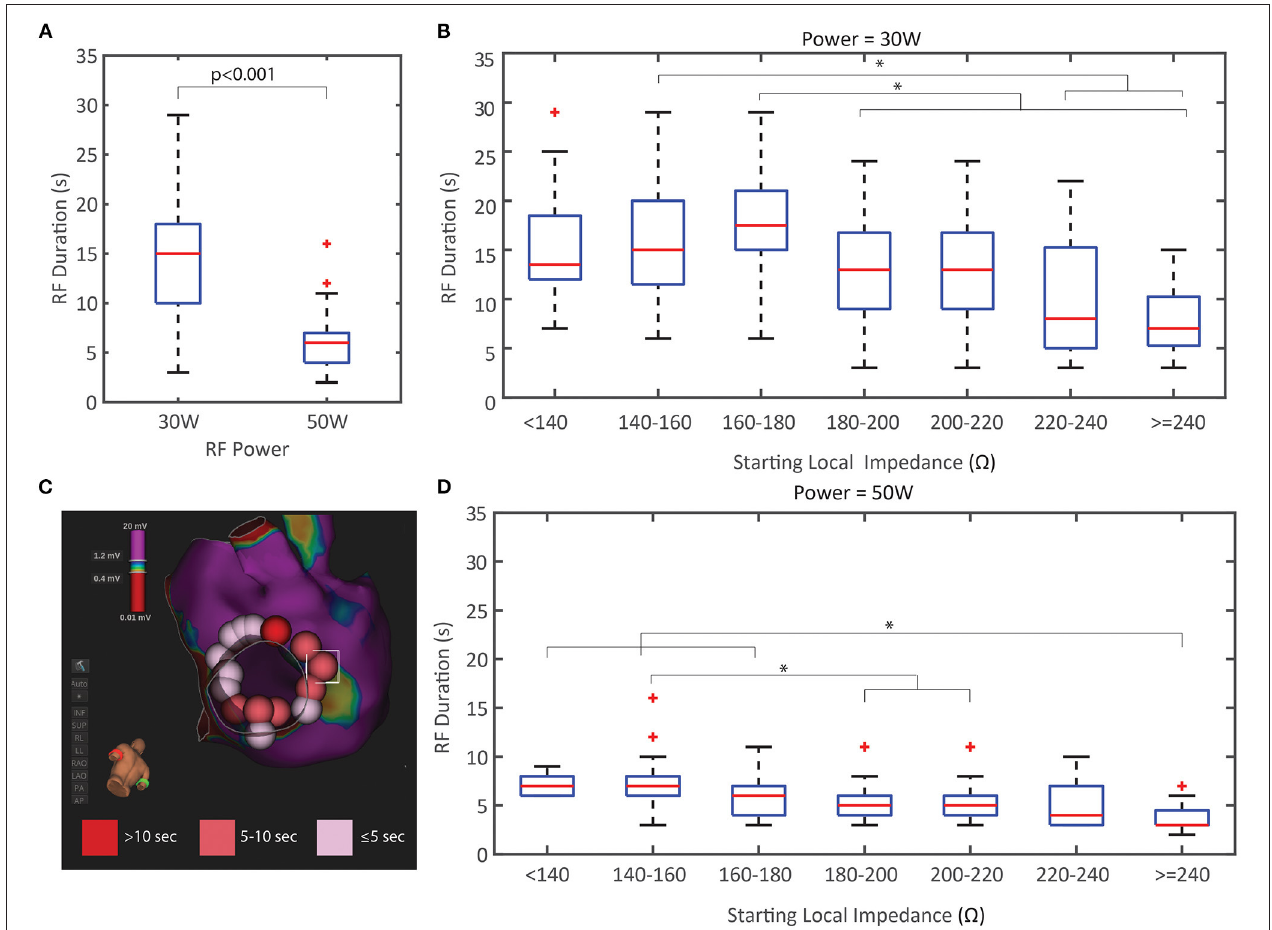
FIGURE 5 | Duration of RF Energy Titration by Power and Starting Local Impedance. (A) RF duration was significantly less in the 50W cohort compared to the 30W. (B,D) RF duration distribution based on the starting local impedance for the 30W cohort (B) and 50W (D) both demonstrate an inverse relationship where higher starting impedances results in shorter RF durations. (C) Representative example of LIPV isolation at 50W with ablation tags colored by RF time showing the spatial distribution of < 5s applications. ∗ indicates statistical significance.